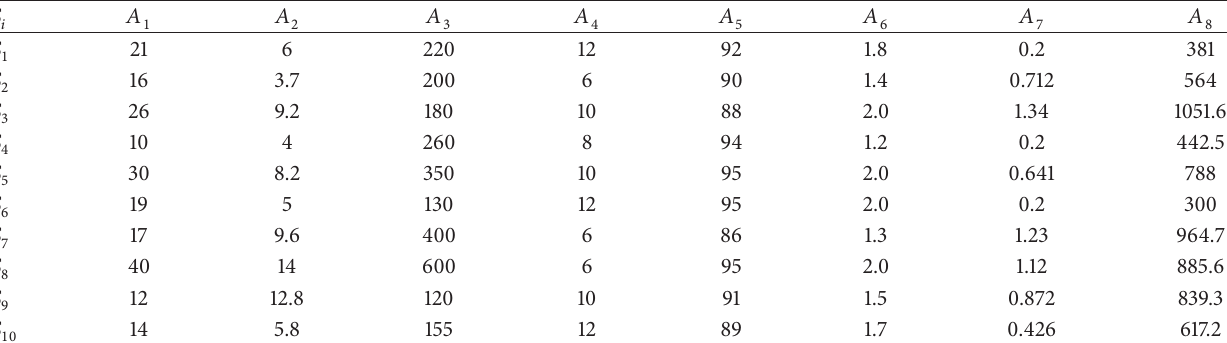
Table 2: Index values processed based on final target centre.